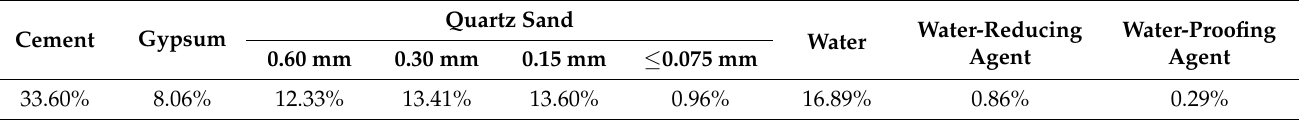
Table 1. The ratio of concrete